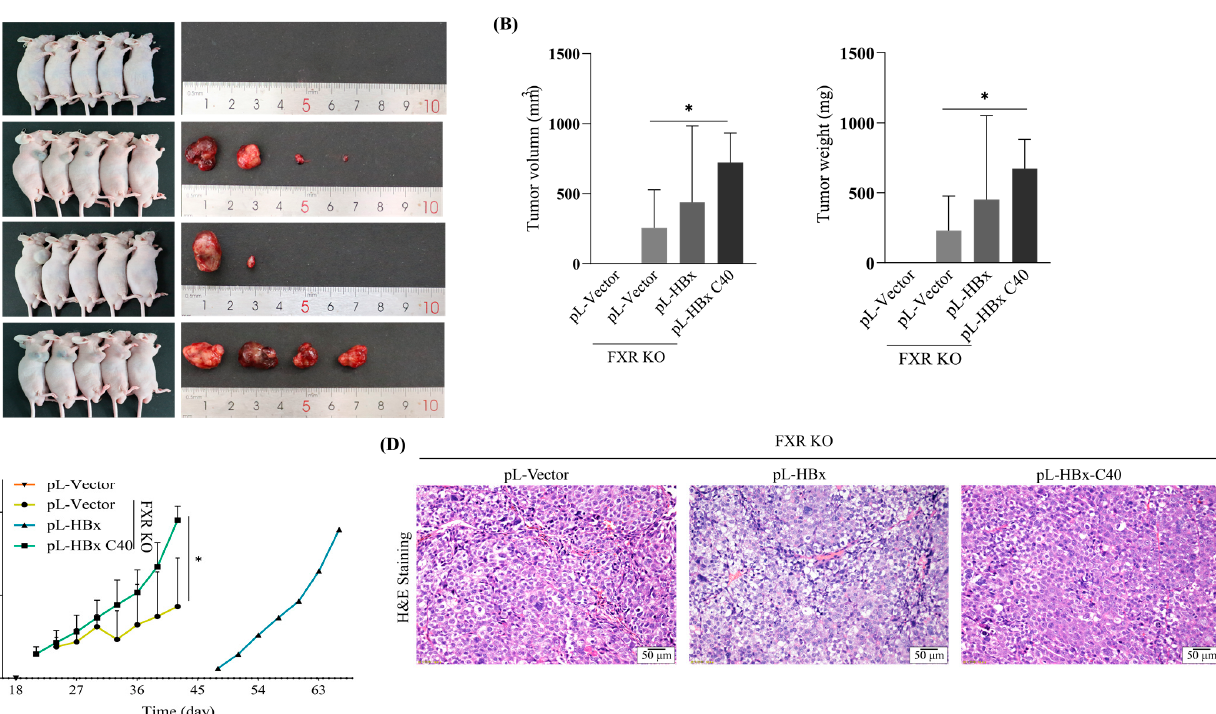
Figure 4. Effect of HBx or HBx C40 on transient mouse models. ( A ) Mouse model scheme of HBx C40 transient overexpression by hydrodynamic gene delivery. ( B ) Protein expression of HBx, and HBx C40 24 h after hydrodynamic gene delivery in wild-type or Fxr − / − mice. ( C ) Ratio of the liver to body weight. ( D ) Representative images of H&E staining of mouse liver in each group are shown. Scale bar = 100 μ m. ( E ) The mRNA expression of Fxr, Shp, c-Myc, Tgf- β 1, cyclin D1, Mad2l2, and p21. * p < 0.05, ** p < 0.01, *** p < 0.001, ns no significance.